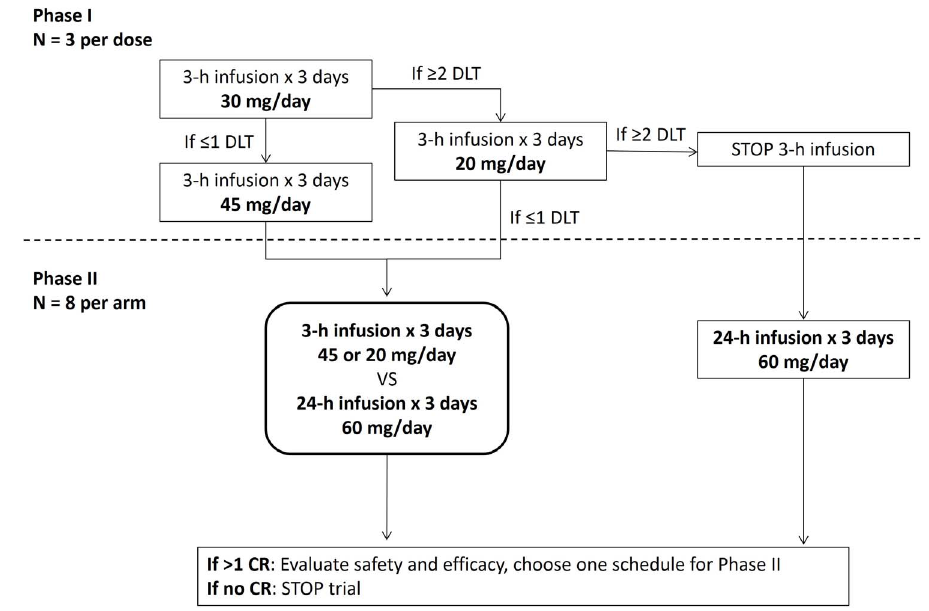
Figure 1. Study design. CR, complete response; DLT, dose-limiting toxicity.